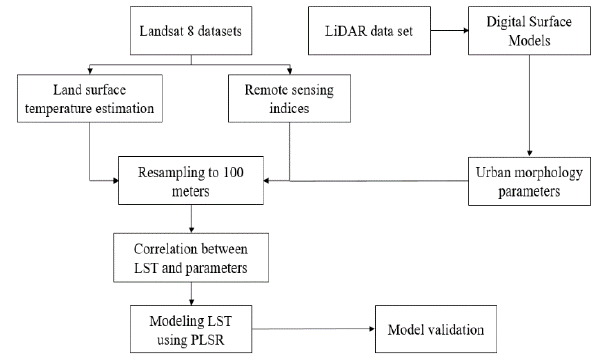
Figure 1. Flowchart of the method used in this